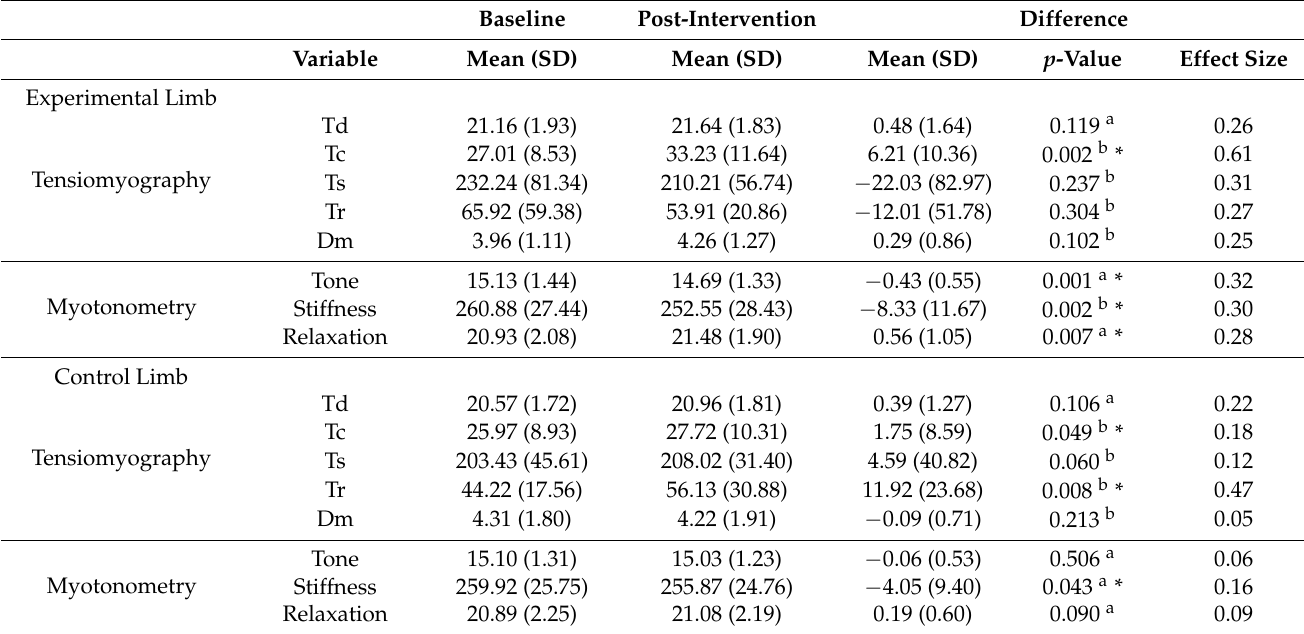
Table 2. Outcomes intragroup.